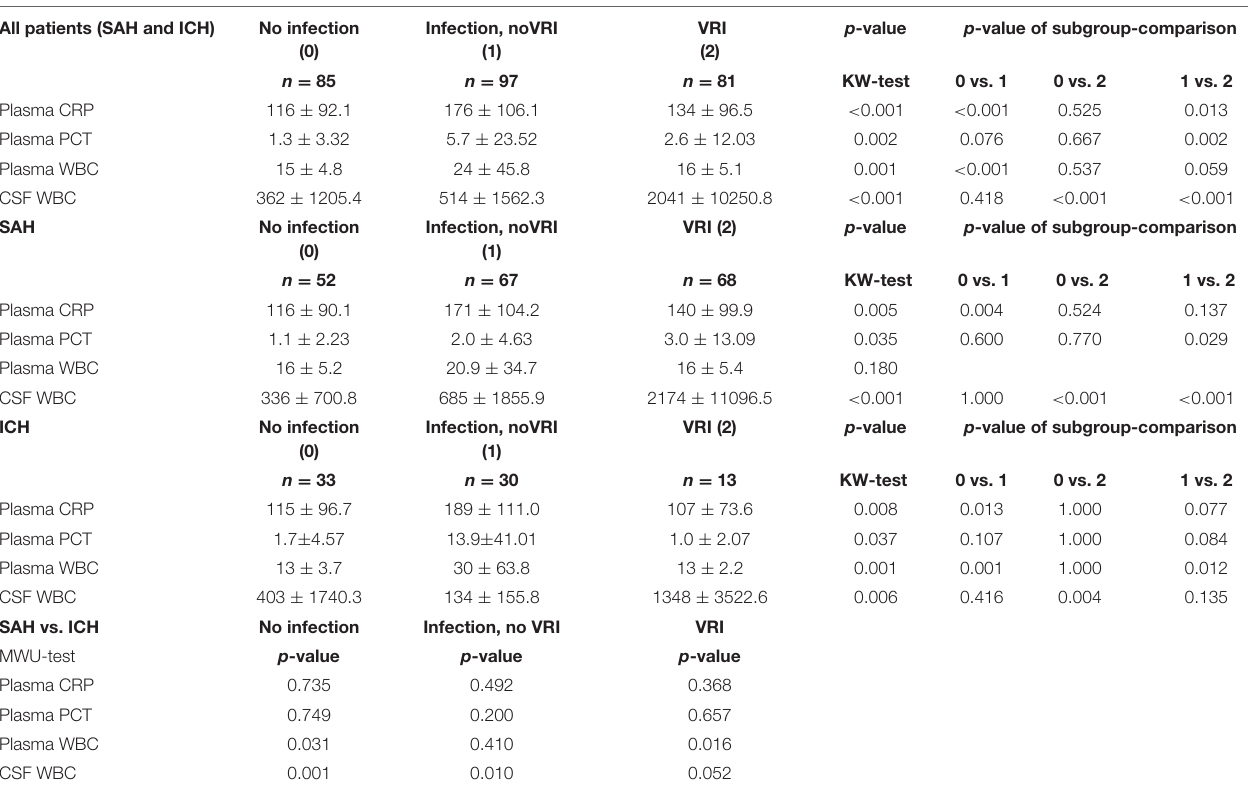
TABLE 2 | Laboratory parameters. All patients (SAH and ICH) No infection